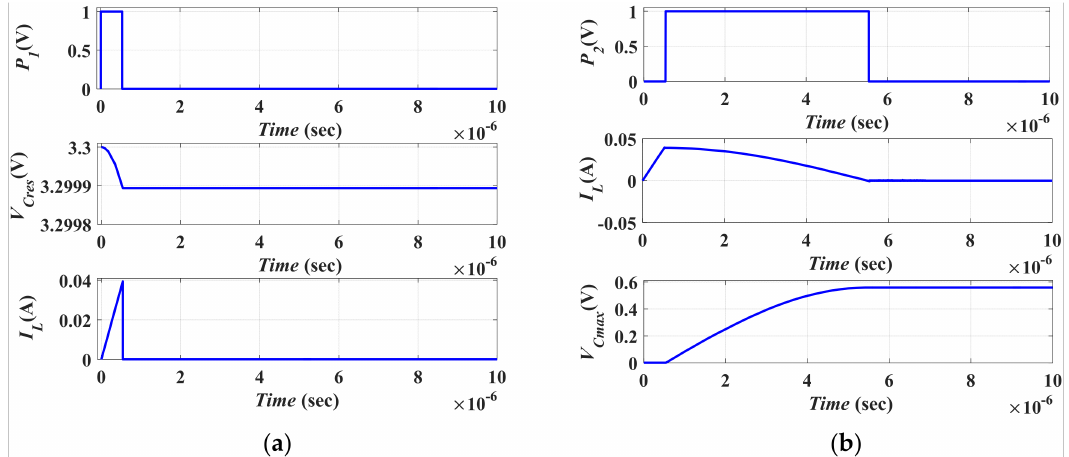
Figure 11. The first stage simulation results ( a ) The charging operation of L from C res , and ( b ) The Simulation result of P 2 , and the voltage on C max and I L